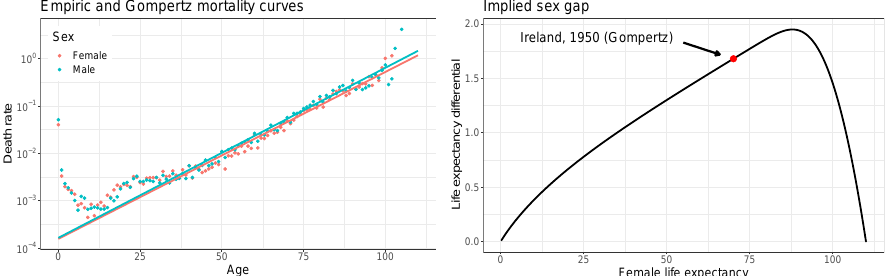
Figure 6. Mortality and implied sex gap for Ireland, 1950. In the left panel, the Gompertz fit is superimposed as solid